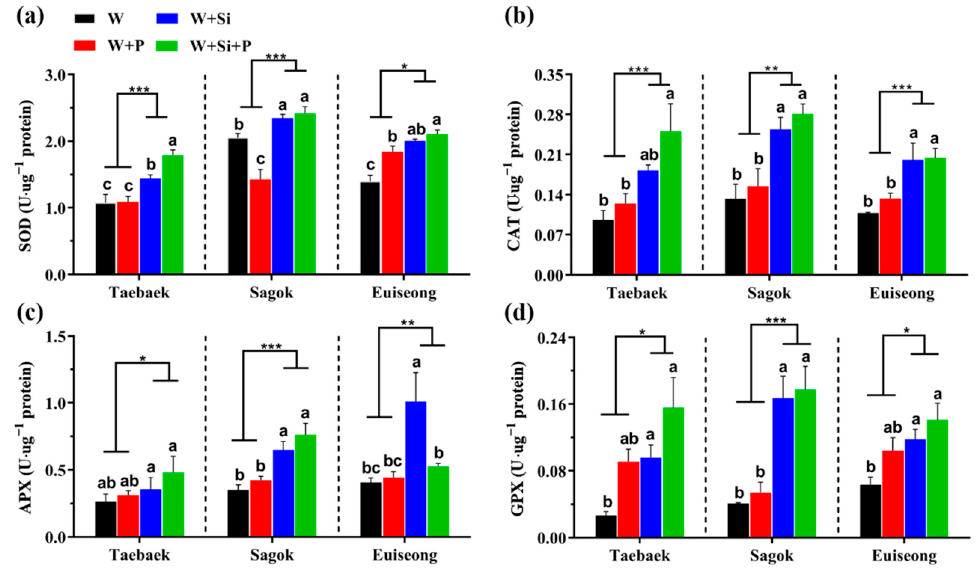
Figure 3. Activities of key antioxidant enzymes: ( a ) superoxide dismutase (SOD), ( b ) catalase (CAT), ( c ) ascorbate peroxidase (APX), and ( d ) guaiacol peroxidase (GPX) in cut peony petals of ‘Taebaek’, ‘Sagok’, and ‘Euiseong’ as affected by the four treatments. Data are the average ± SE generated from n = 4 technological replicates. Statistical differences among four treatments were determined by Duncan’s multiple comparison range test at p = 0.05 and denoted by different lowercase letters. The signi fi cant di ff erences between the Si ( − ) and Si (+) were determined following an unpaired two- tailed Student’s t test at p ˂ 0.05 (*), ˂ 0.01 (**), and ˂ 0.001 (***), Si ( − ) was regarded as the control group.